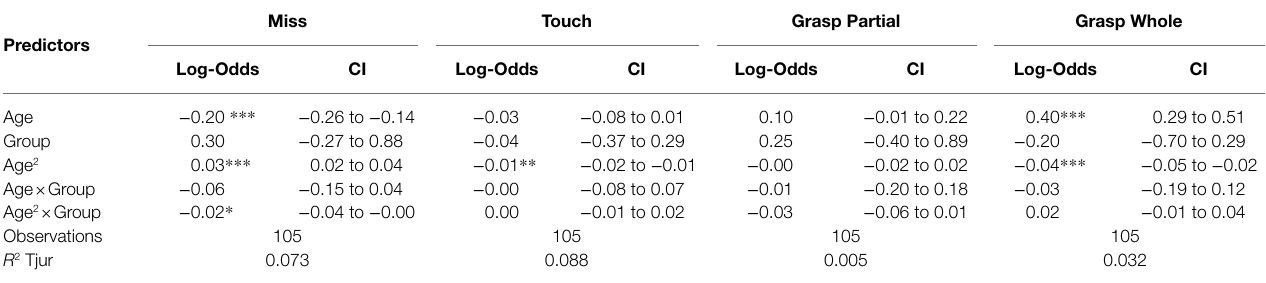
TABLE 4 | Mixed-effects weighted logistic regression on four reaching outcomes on adjusted-age (10-day increase), adjusted age-squared, group (at risk or typical development), and interactions. Miss Predictors